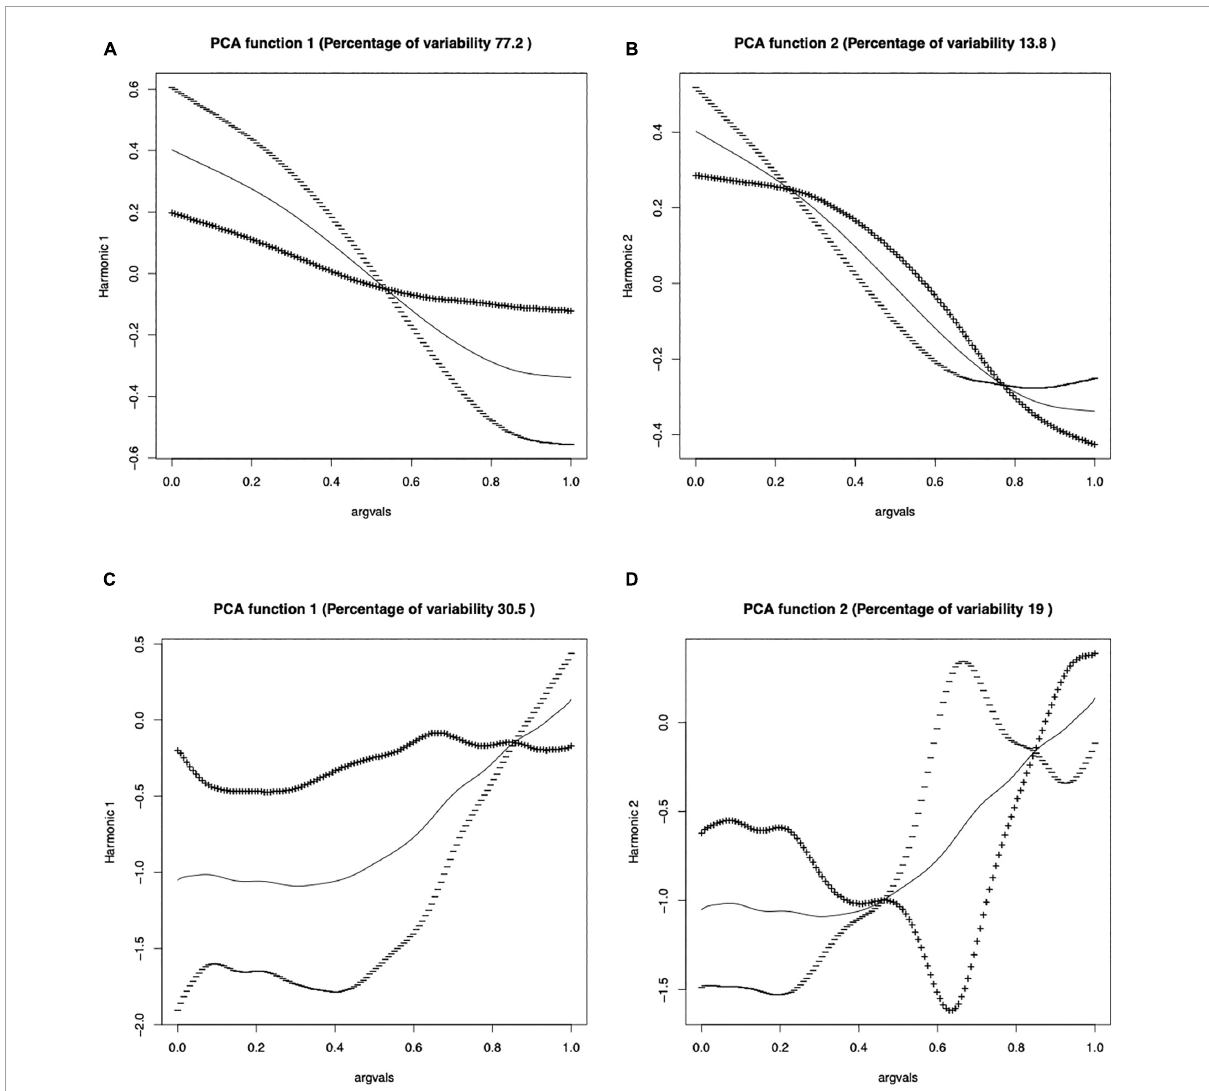
FIGURE6 The results of FPCA for (A) PC1 (t) and (B) PC2 (t) of T1 for F0 curves [ (A) s 1 ; (B) s 2 ] and F0 velocity profiles [ (C) s 1 ; (D) s 2 ] in the HF lexical condition for the young